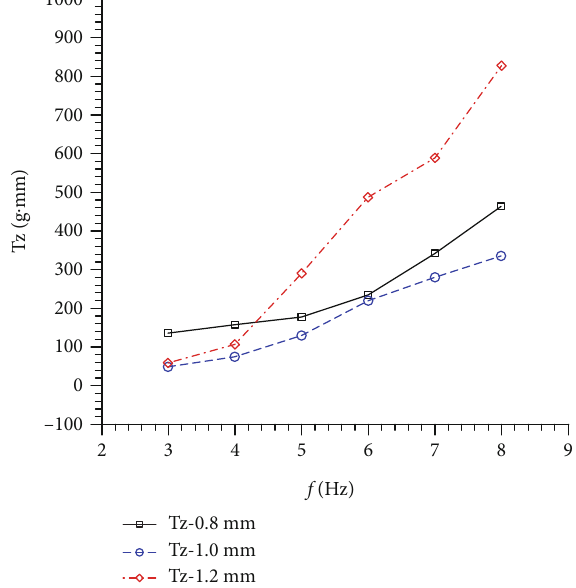
Figure 19: Relationship between sti ff ness and pitching